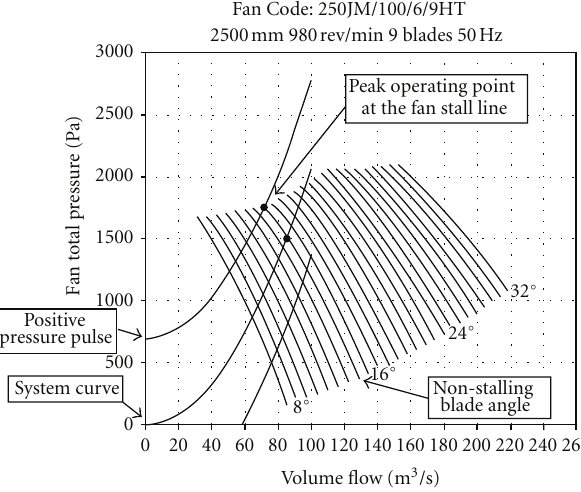
Figure 8: Optimum fan selections for a common duty point, fan selection strategy one: nonstalling blade stagger angle.